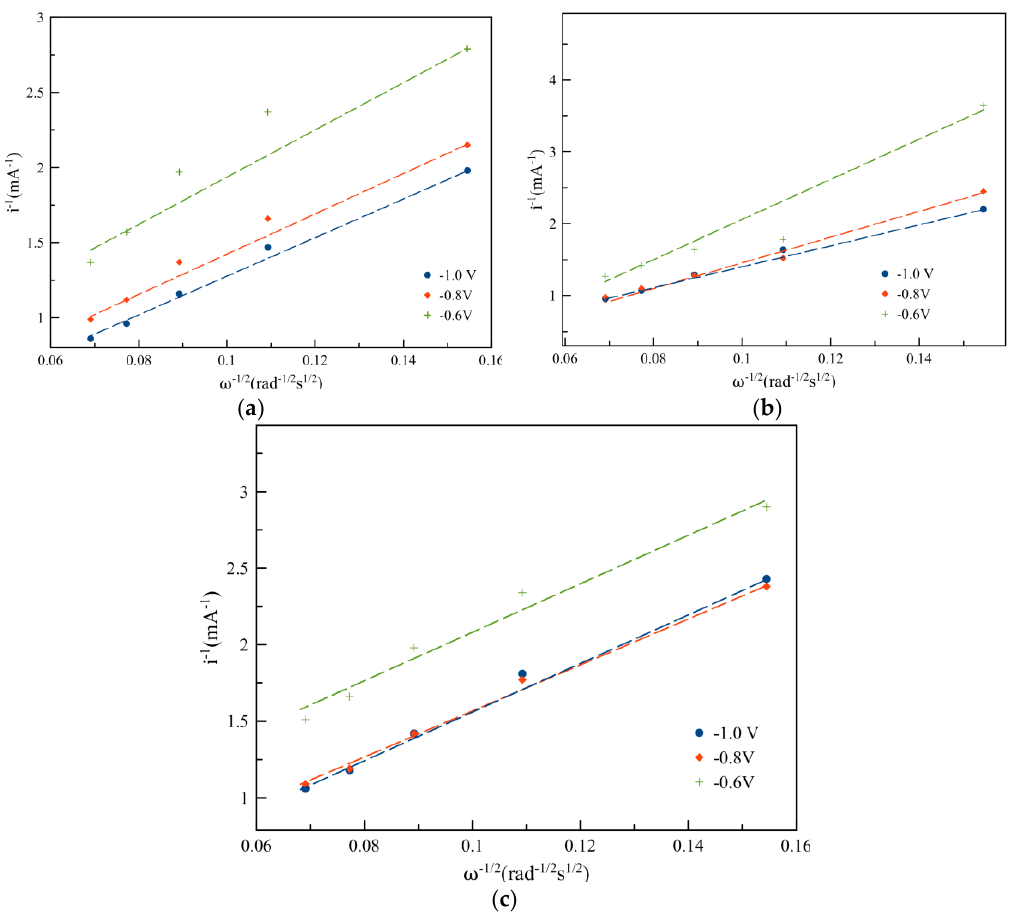
Figure 5. Koutecky–Levich plot for ( a ) nanoflower-like MnO 2 , ( b ) nanoflower–nanowire-like MnO 2 and ( c ) nanowire-like MnO 2 / carbon Vulcan XC 72 electrode at the various